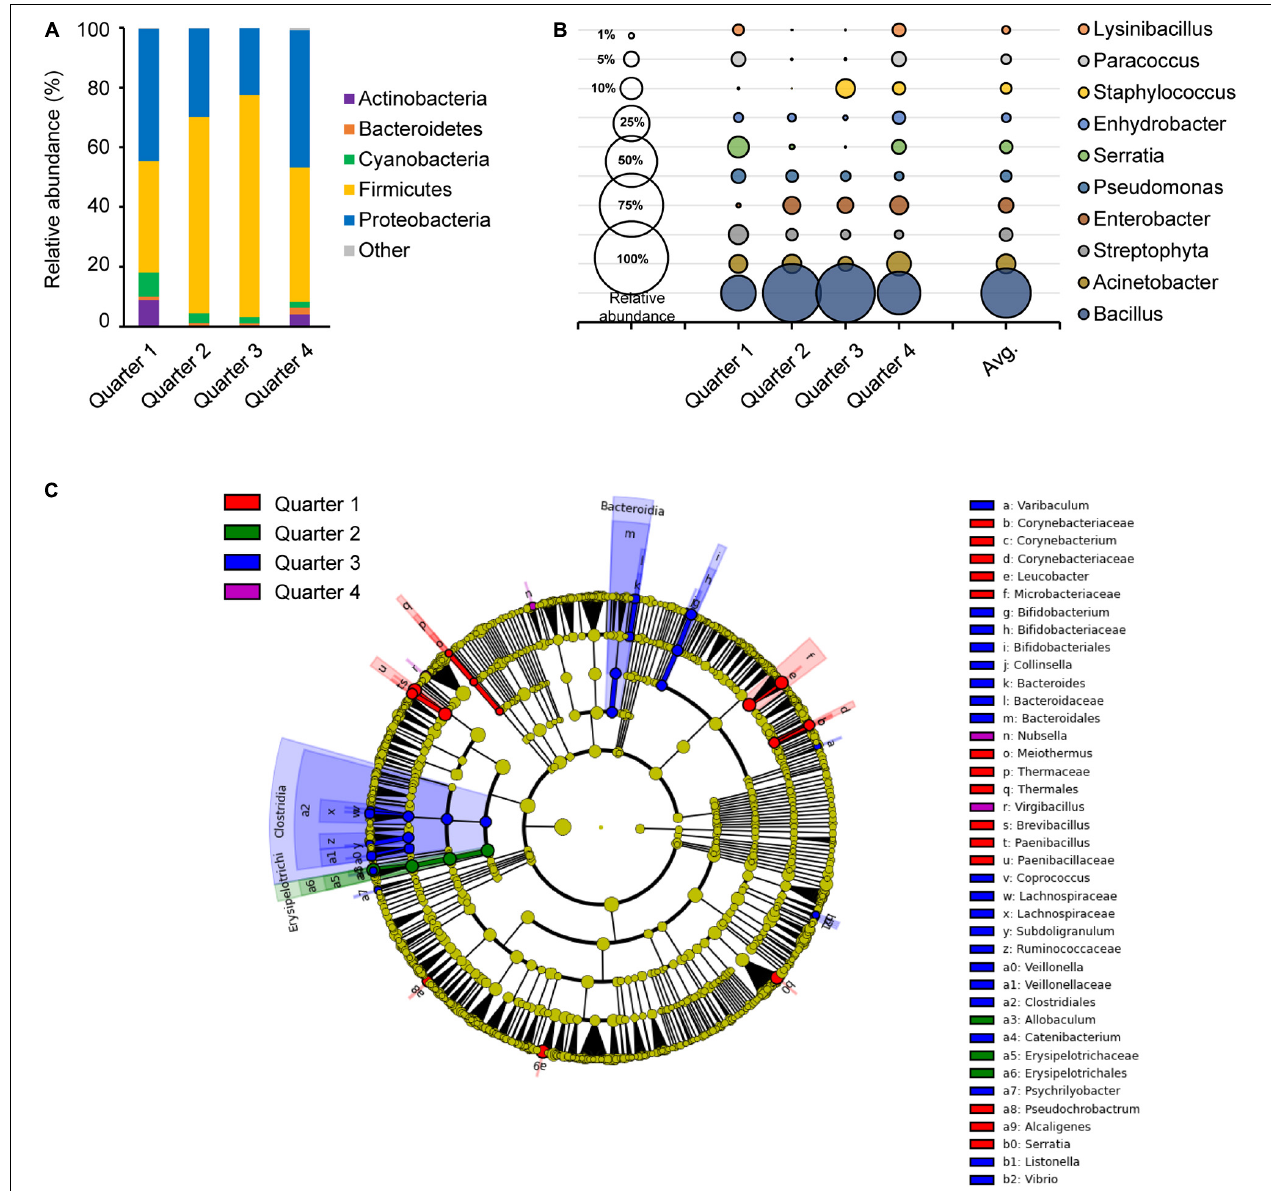
FIGURE 3 | Comparison of the bacterial distribution in each sampling time point. Relative abundances at phylum level (A) and genus level (B) , and the LEfSe cladogram (C) of taxonomic LDA score higher than 3.0 by each sampling time point in 1 year; quarter 1, quarter 2, quarter 3, and quarter 4 are indicated as red, green, blue, and purple,